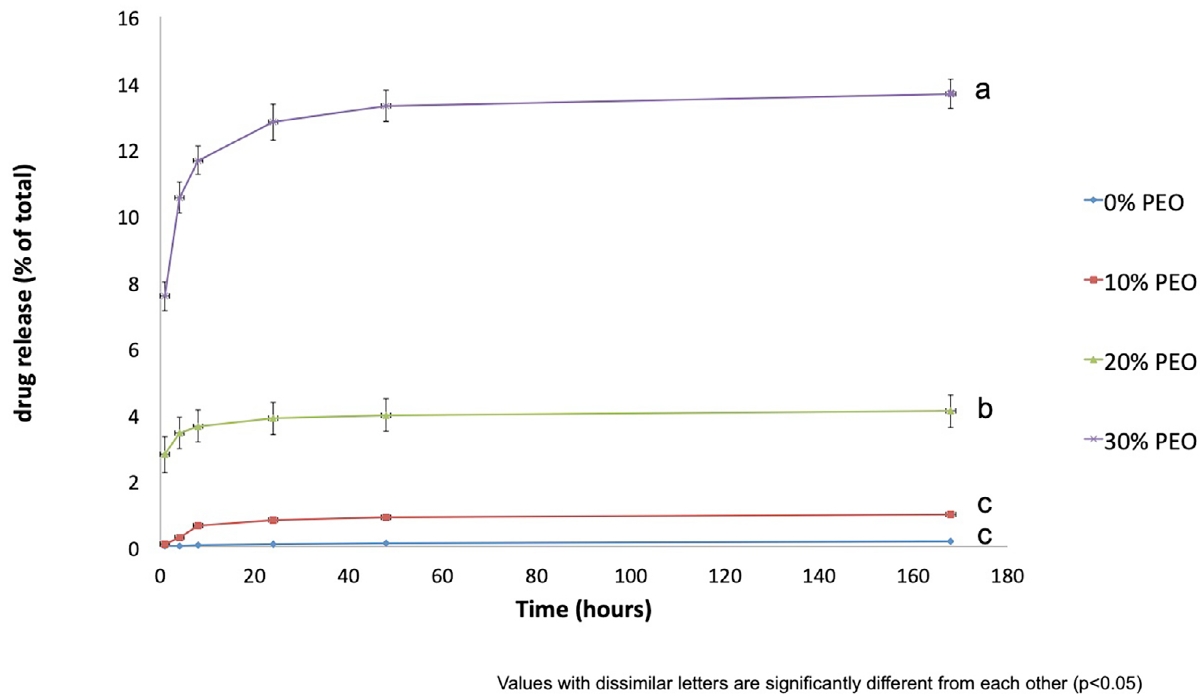
Figure 1- Release of doxycycline from PMMA fibers +/- PEO at 0%, 10%, 20%, or 30%